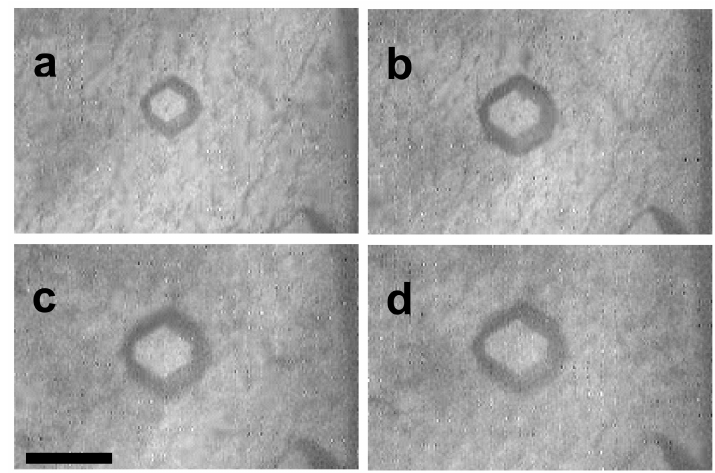
Figure 2. Growth of a crystal nucleated on the substrate. ( a ) 0 h ( σ = 4.0), ( b ) 25.6 h ( σ = 4.0), ( c ) 32.0 h ( σ = 5.6), ( d ) 96.2 h ( σ = 5.6) after start of observation. Normal growth rates ( R ) of a {101} face (top surface of the crystal) were calculated by measuring the lengths and angles of the crystal edges, and adjusting the angle of the {101} face. Scale bar represents 100 µ m.